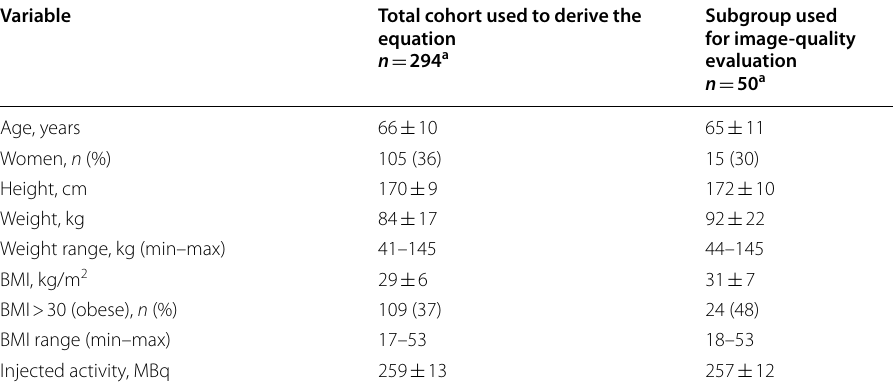
The data are expressed as mean standard deviation unless otherwise indicated ± BMI, body mass index a The 294‑patient cohort was used to derive the equation between MS and body weight while the 50‑patient subgroup